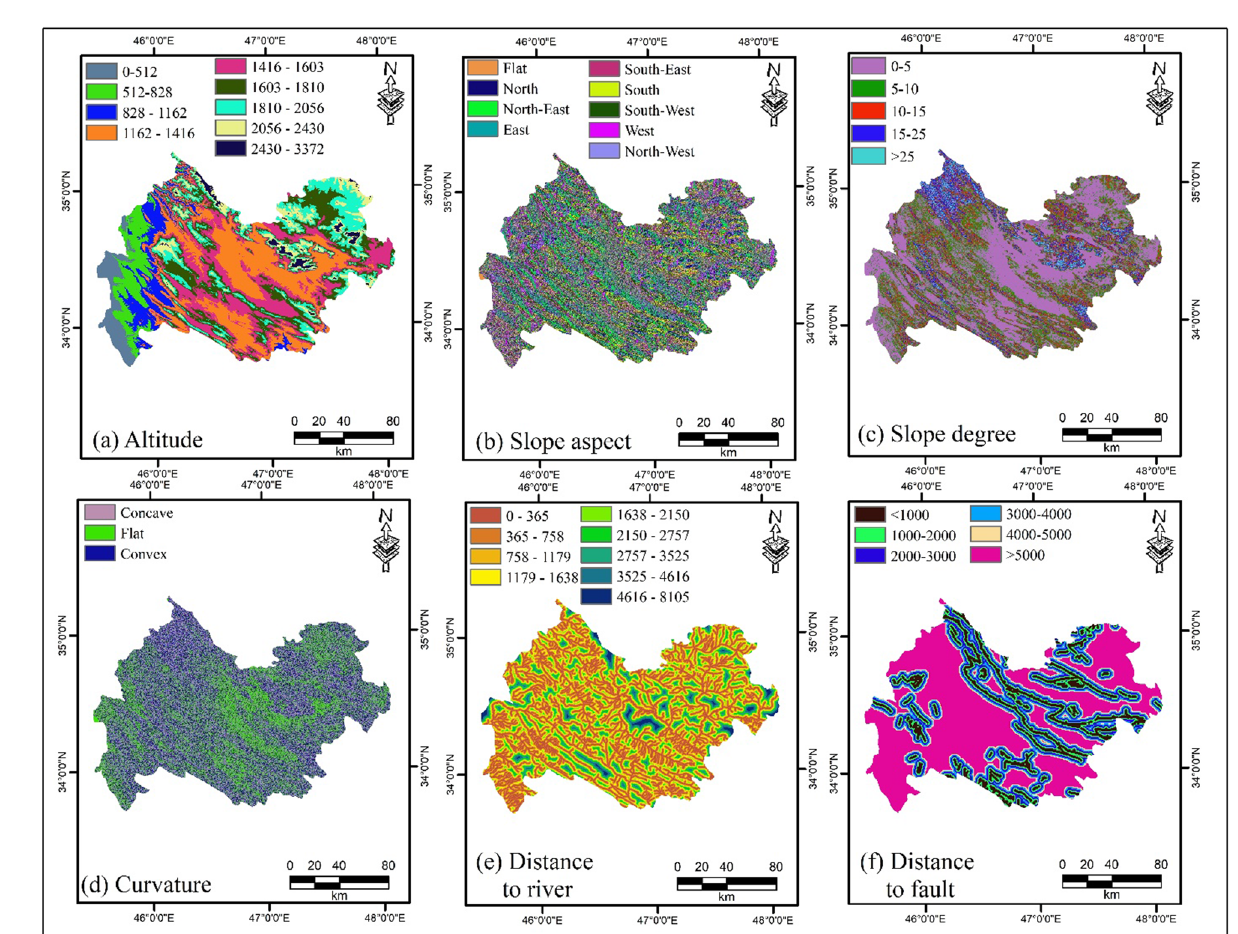
Figure 8. Map of multi-hazard influencing factors: ( a ) Altitude, ( b ) slope aspect, ( c ) slope degree, ( d ) curvature, ( e ) distance to river, ( f ) distance to fault, ( g ) distance to road, ( h ) lithology, ( i ) rainfall, and ( j ) land use using ArcGIS 10.3.1